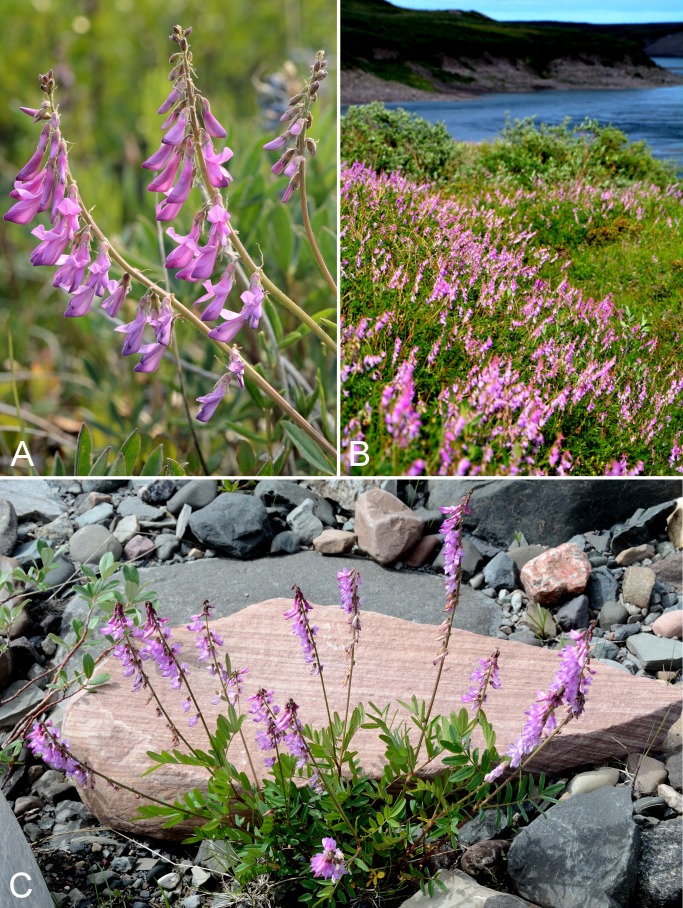
Hedysarum americanum.(A) Inflorescence, Kugluk (Bloody Falls) Territorial Park, Nunavut, 13 July 2014. (B) Habitat, Kugluk (Bloody Falls) Territorial Park, Nunavut, 17 July 2014. (C) Habit, Kugluk (Bloody Falls) Territorial Park, Nunavut, 19 July 2014. Photographs by R. D. Bull (A, C) and P. C. Sokoloff (B).